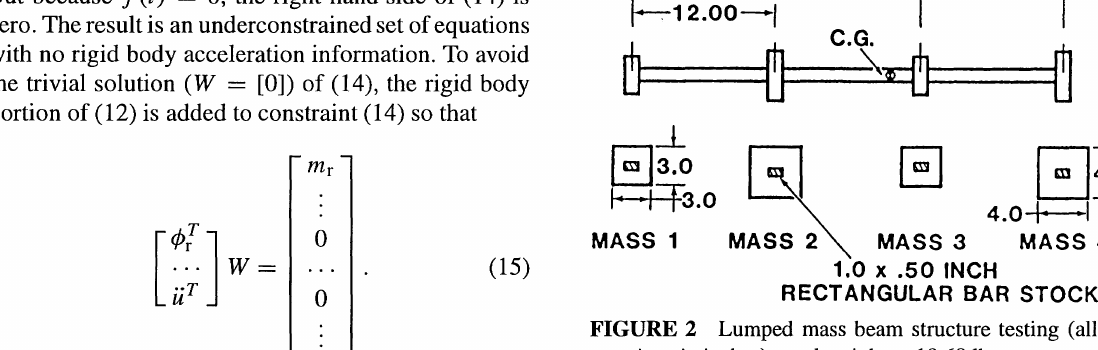
FIGURE 2 Lumped mass beam structure testing (all di mensions in inches); total weight = 18.68